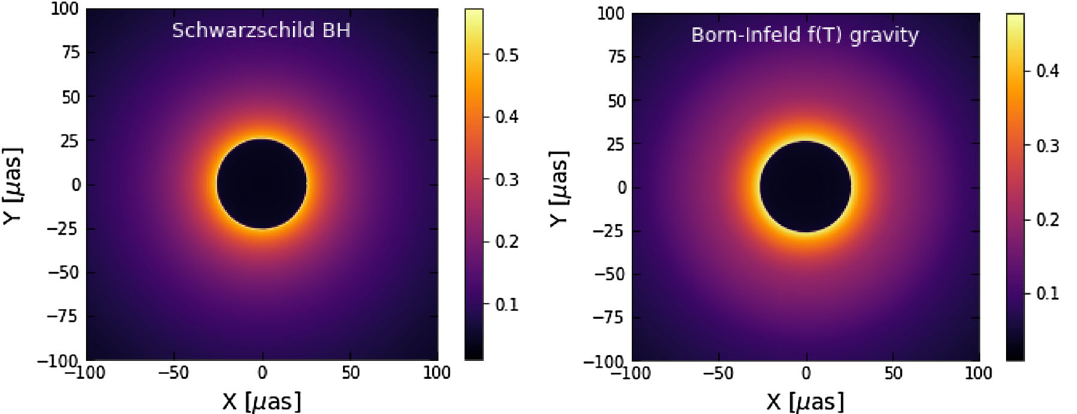
Fig. 3 Shadow images of Sgr A (cid:2) black hole in GR (left panel) and Born–Infeld f ( T ) gravity (right panel) using the best fit parameters. We have considered the best fit for the black hole mass given in Table 1 and the distance form the Sgr A (cid:2) to Earth D = 8 . 3